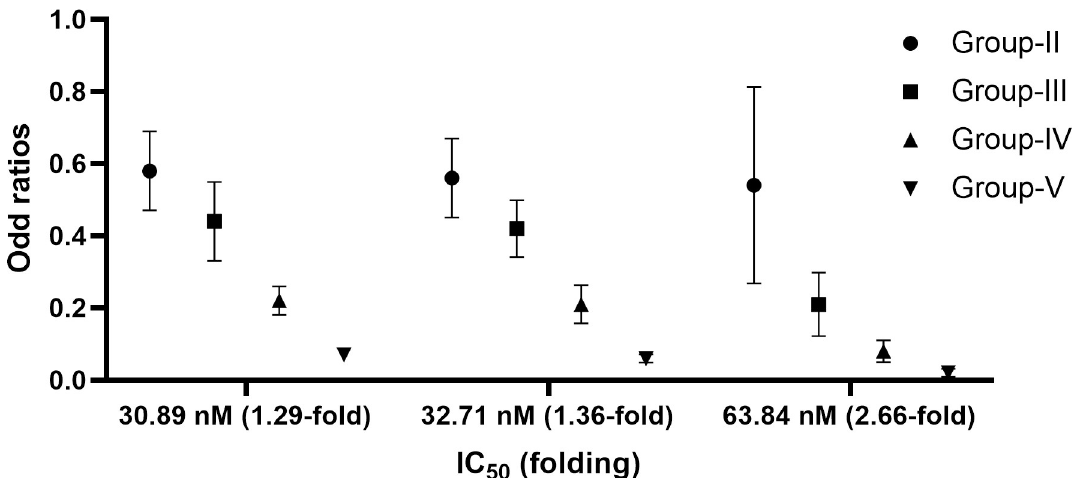
Fig 8. Comparisons ofodd ratios of regimen-I (a three-day combination of artesunate-mefloquine) with different IC50 values in patients with resistant mefloquine.